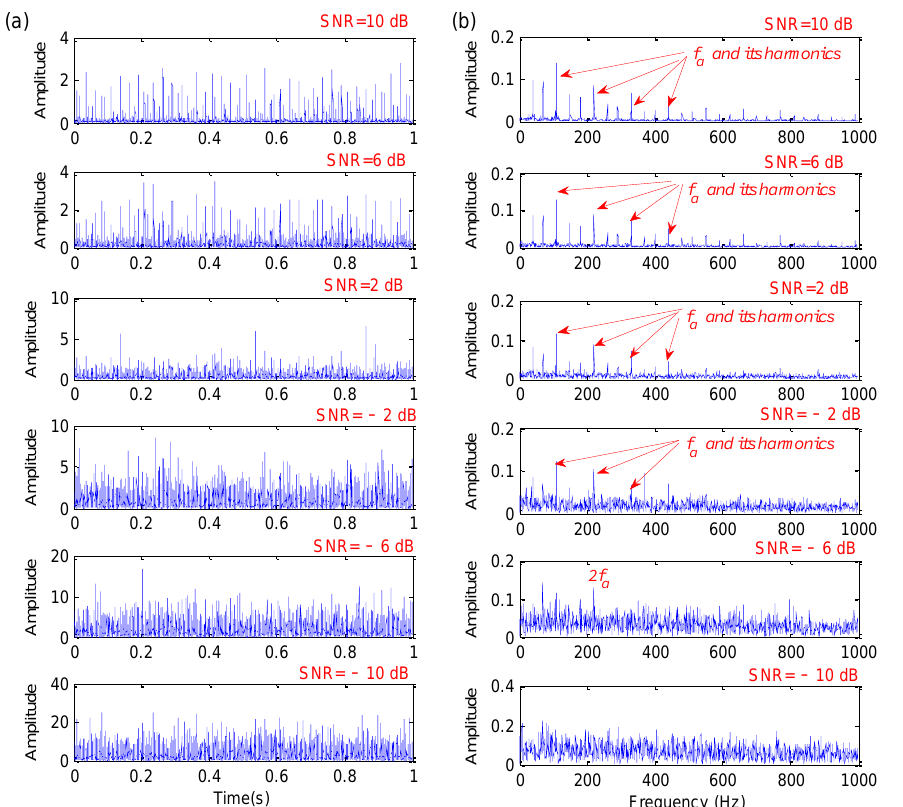
Figure 4. Qualitative analysis results obtained by the proposed method with six levels of noise: ( a ) Time domain waveform; ( b ) envelope spectrum.